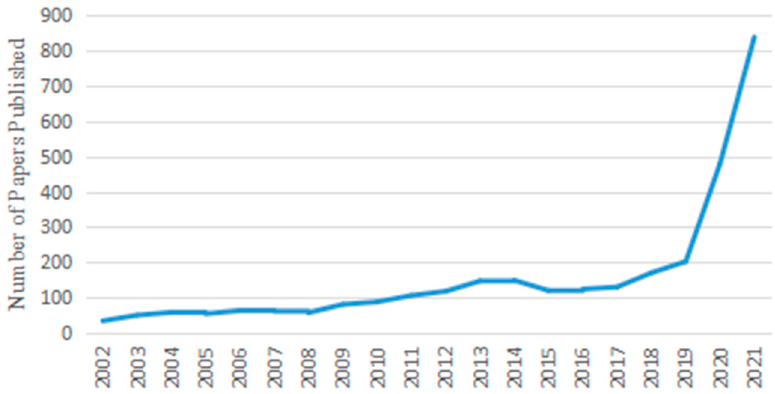
Figure 1. The number of papers published in the field of enterprise digitalization research from 2002 to 2021.